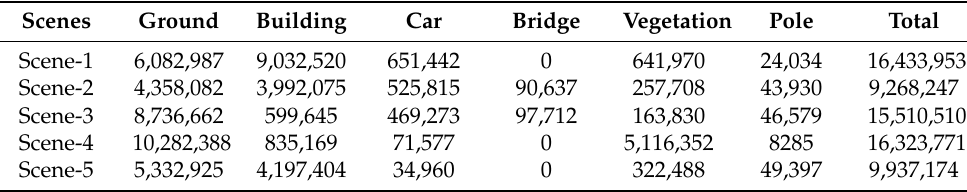
Table 1. Number of points in each scene and each category in the